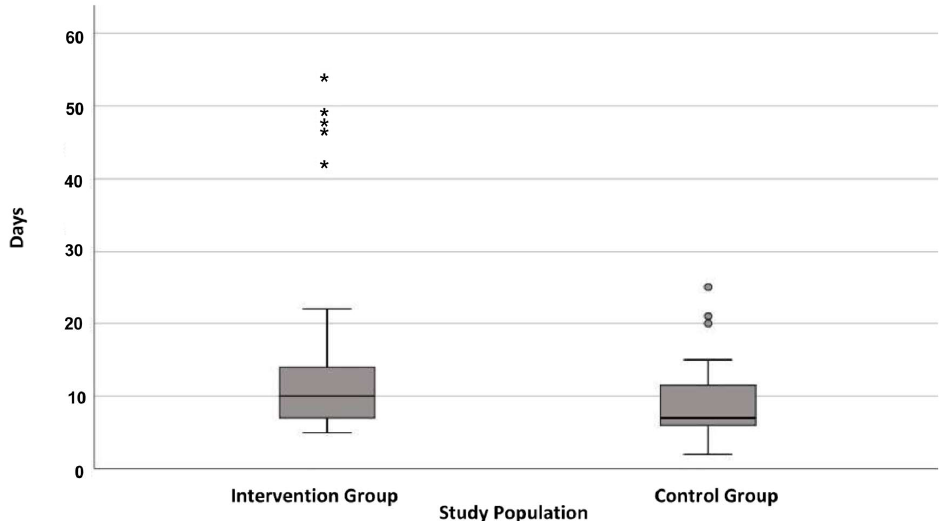
Figure 2. Boxplot on days between surgery and postoperative nutritional consultation. outlier, * extreme outlier.